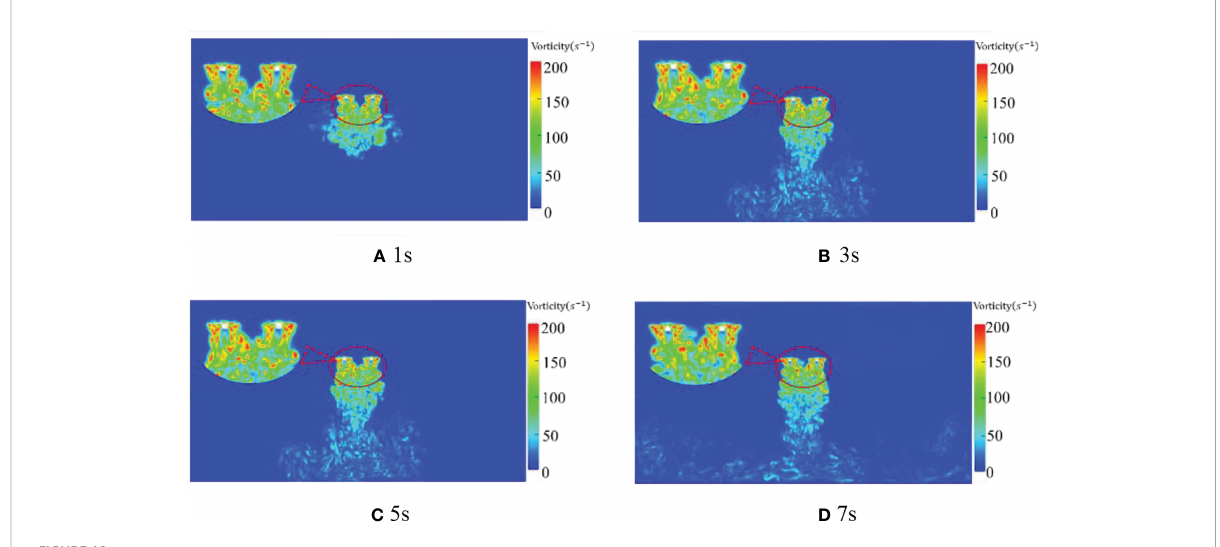
FIGURE 10 Distribution of rotor vorticity at different times and 2500